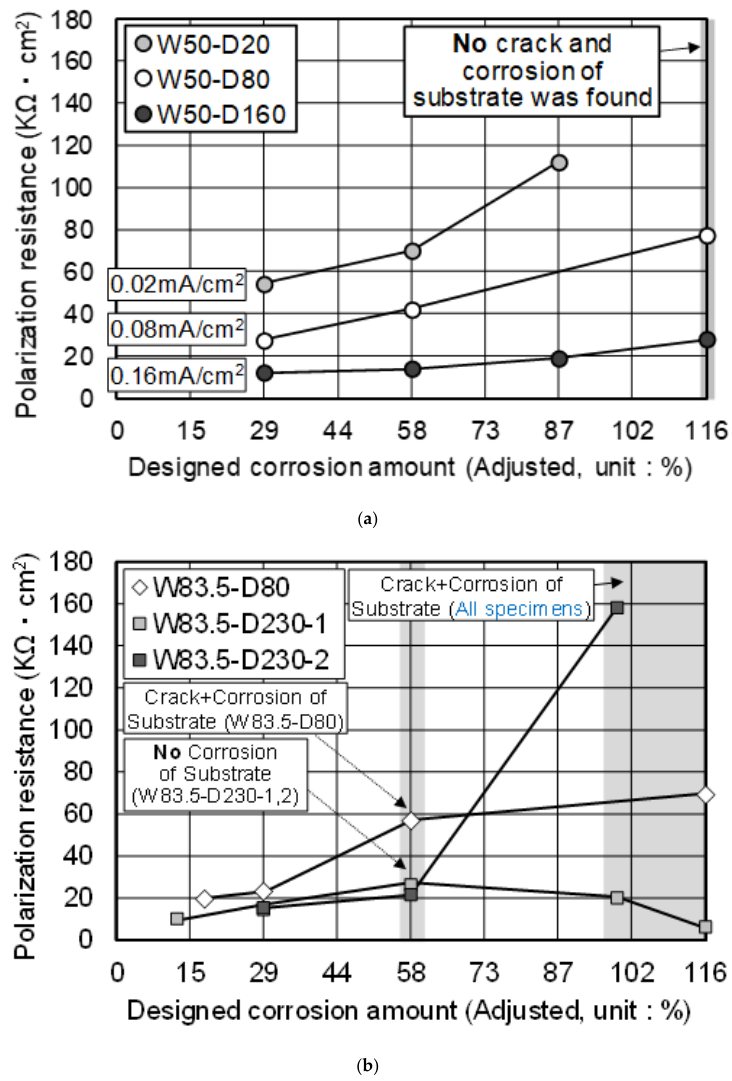
Figure 7. ( a ) Behavior of Rp (w/c = 50% concrete); ( b ) Behavior of R p (w/c = 83.5% concrete).